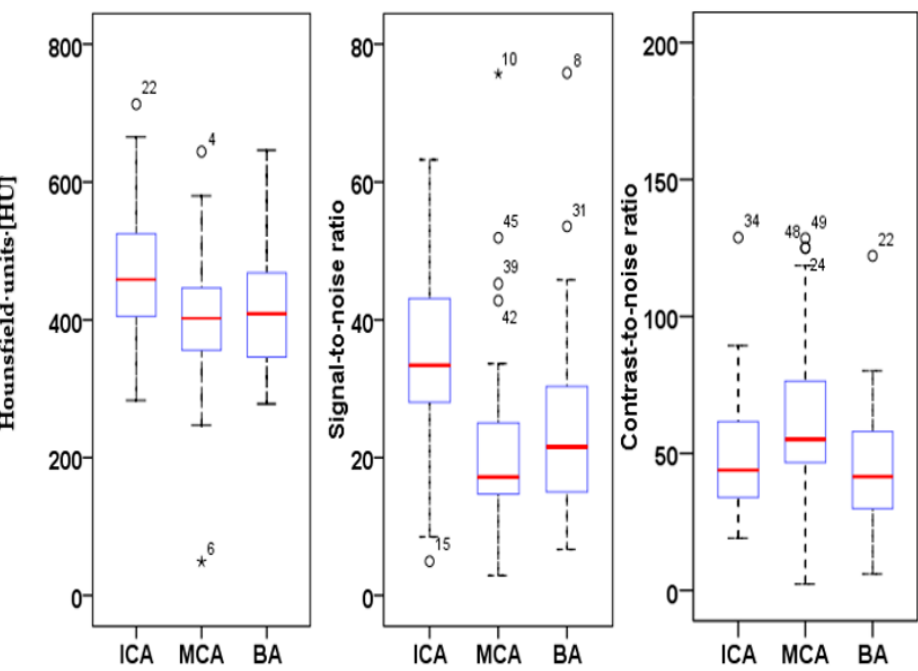
Figure 1. Boxplot of HU, SNR and CNR of the quantitative analysis of the internal carotid artery (ICA), middle cerebral artery (MCA) and basilar artery (BA) of 50 UHR-CTA images. Table 1. Medians and interquartile range (IQR) of qualitative parameters of 50 UHR-CTA images rated by two trained readers